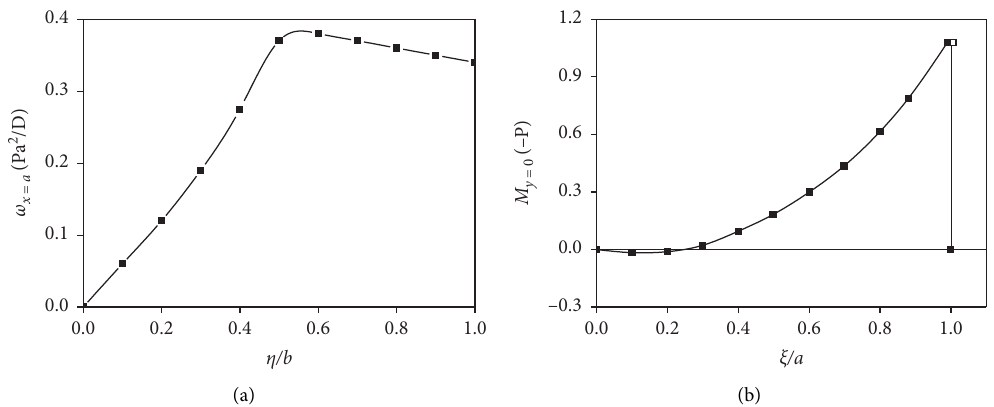
Figure 4: The deflection and bending moment with the concentrated cutting force ( P ) acting on ( a , b /2): (a) the deflection on free side x � a and (b) the bending moment on fixed side y � 0.